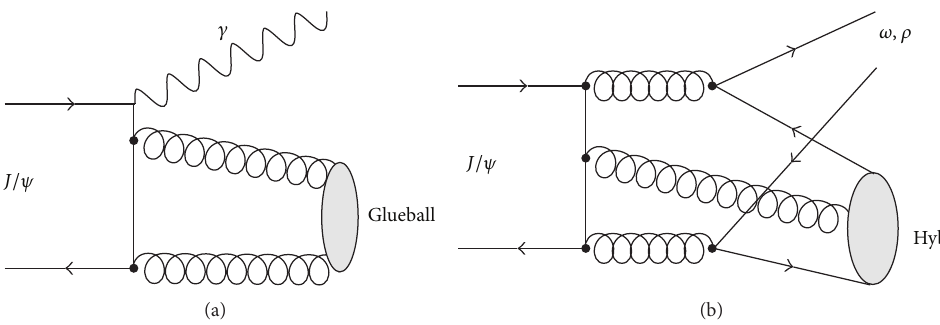
Figure 1: (a) A prior production of glueball in the 𝐽/𝜓 → 𝛾𝑋 𝐺 ; (b) a prior production of hybrid in the 𝐽/𝜓 → 𝜔𝑋 𝐻